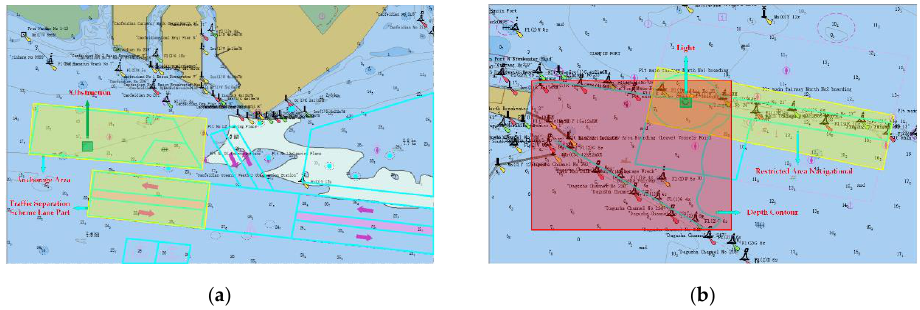
Figure 8. Intersection of features. ( a ) Features of the same types do not overlap; ( b ) Different types of features overlap.